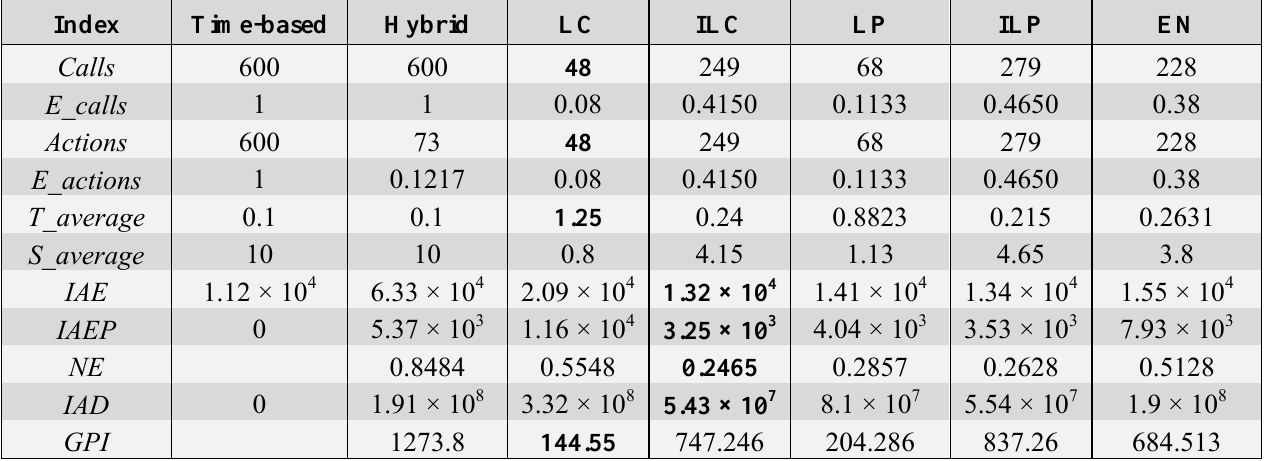
Table 5. Performance indexes of the hybrid and event-based approaches for  Figures in bold represent the best value of every performance index in the hybrid and event-based approaches.